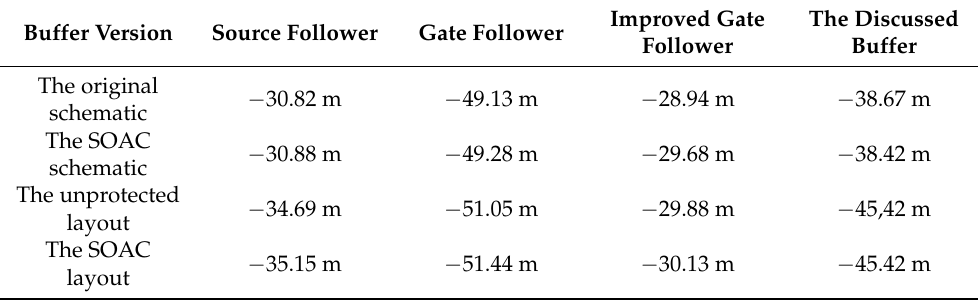
Table 6. Comparison of voltage gain [dB] for different implementation stages of the source follower, gate followers, and discussed buffers.